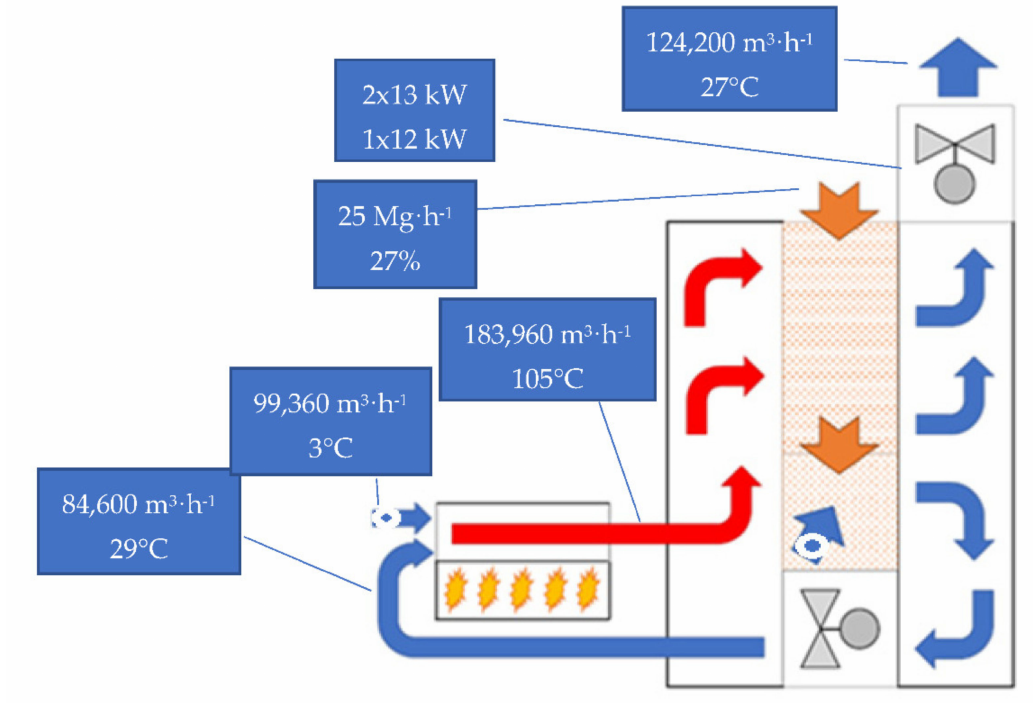
Figure 4. Graphic representation of the research results of the DT2532 dryer.